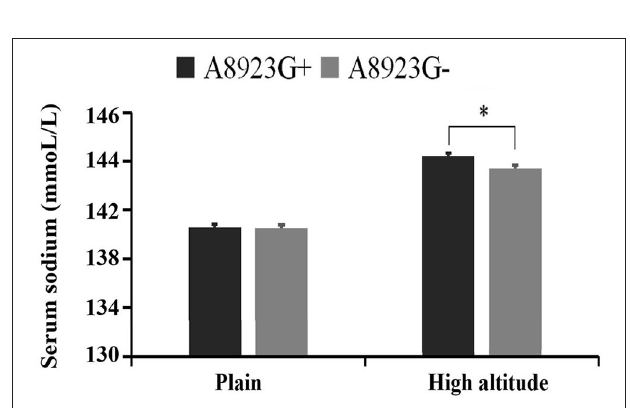
FIGURE 2 | Comparison of blood sodium concentration between A8923G + and A8923G- groups. *Represents statistically significant comparation between A8923G+ group and A8923G- group at high